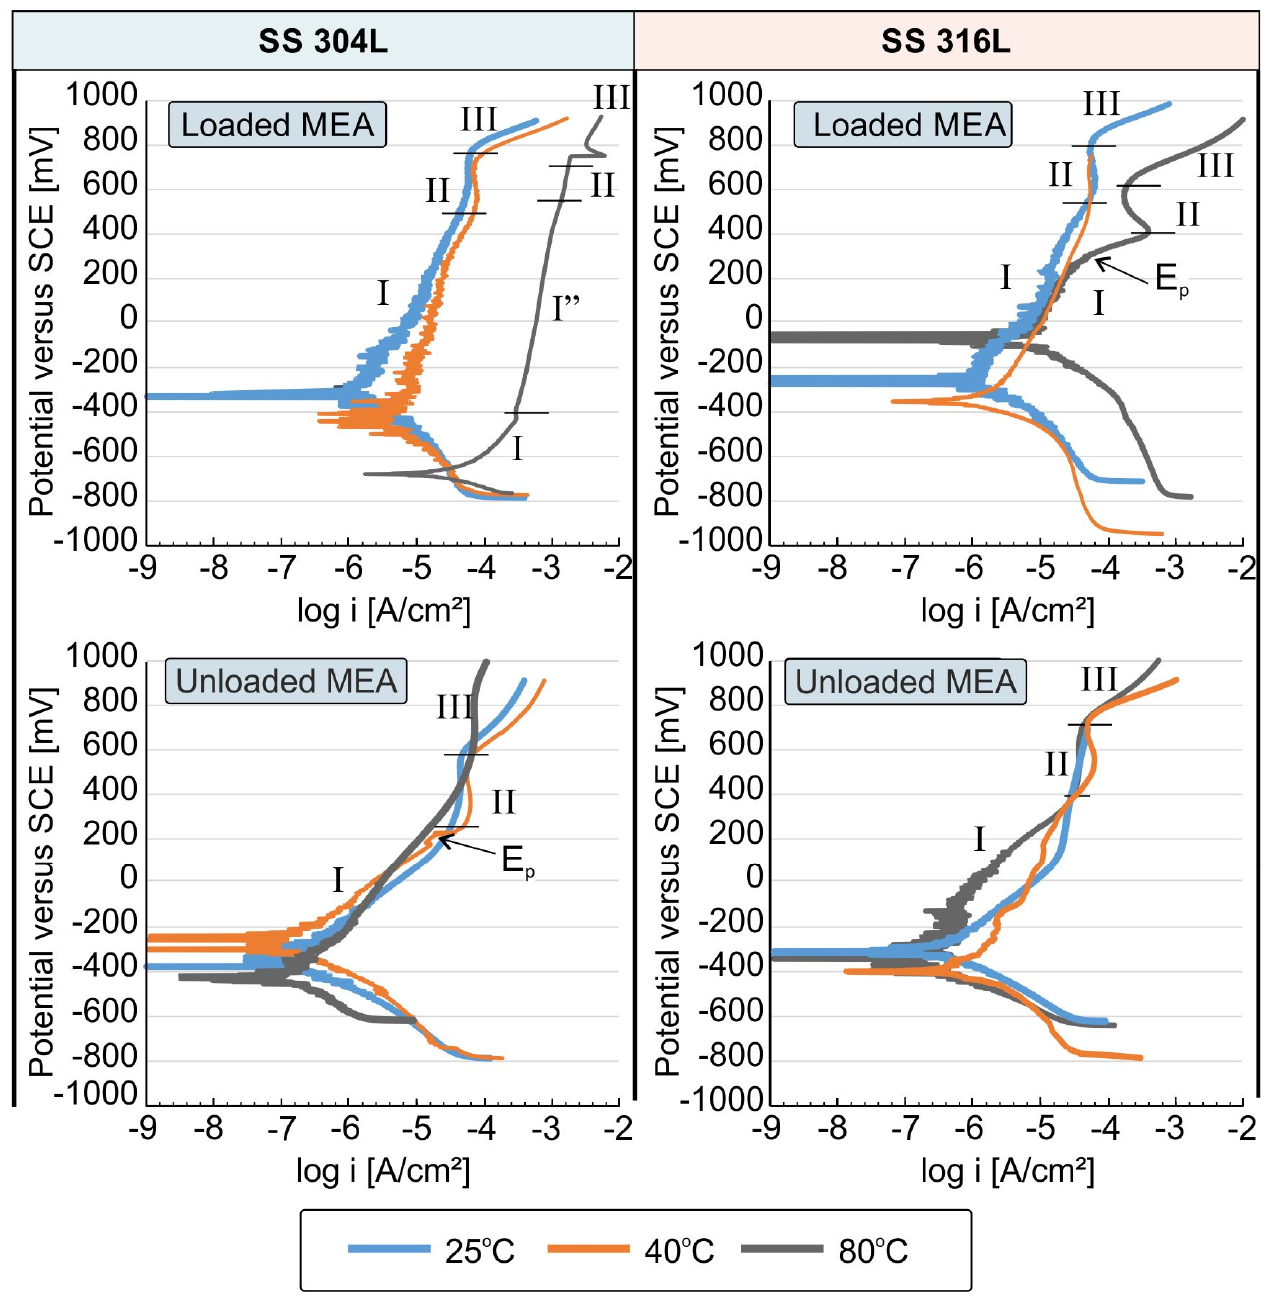
Figure 3. Polarization curves for SS 304L and SS 316L at 25 °C, 40 °C and 80 °C when immersed in unloaded and loaded MEA solution.